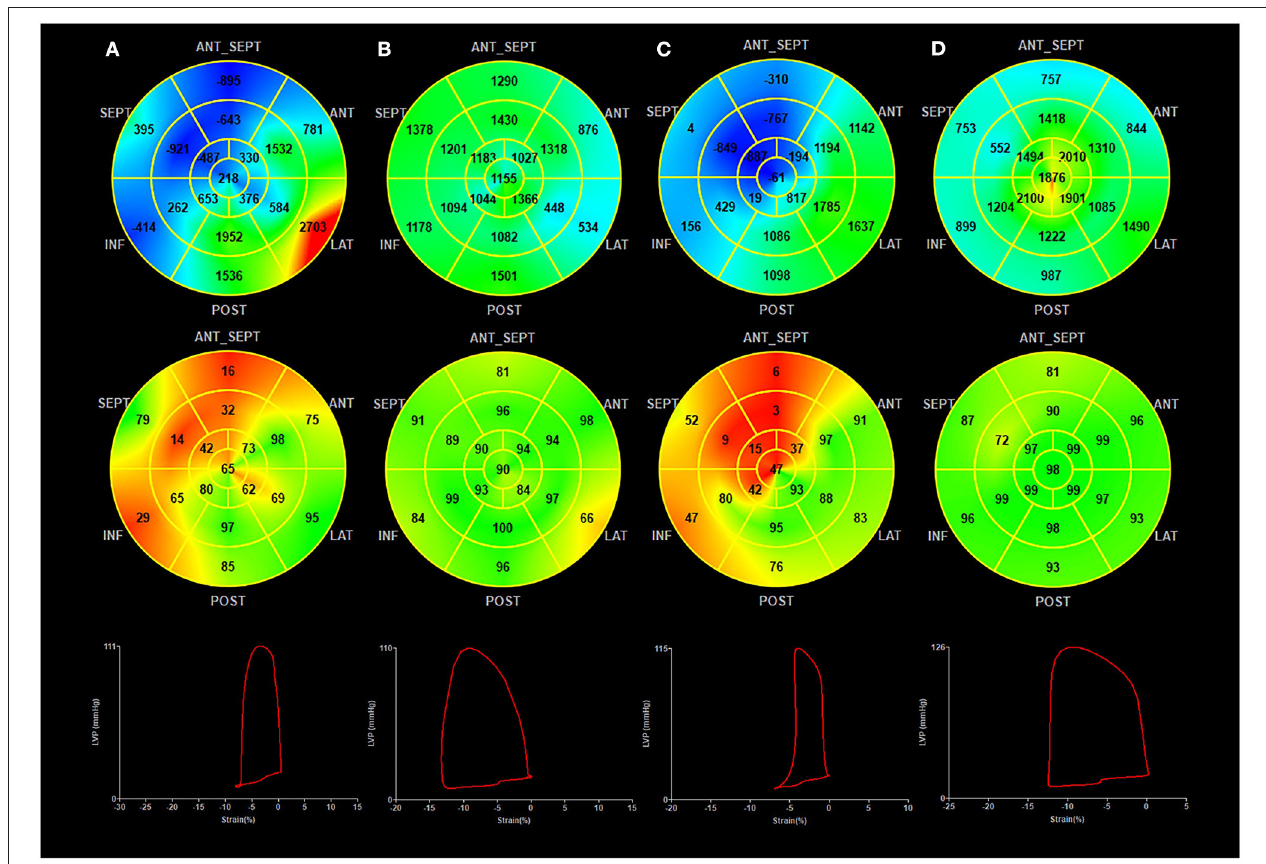
FIGURE 3 | Myocardial work at baseline and follow-up in the BVP and LBBAP groups. (A) BVP at baseline; (B) BVP at follow-up; (C) LBBAP at baseline; (D) LBBAP at follow-up; (Top Panel) Seventeen-segment bull’s-eye of myocardial work index (negative work in blue, normal in green, and areas of high myocardial work coded in red); (Middle Panel) Seventeen-segment bull’s-eye of myocardial work efficiency (high efficiency in green, low efficiency in red); (Bottom panel) Pressure-strain